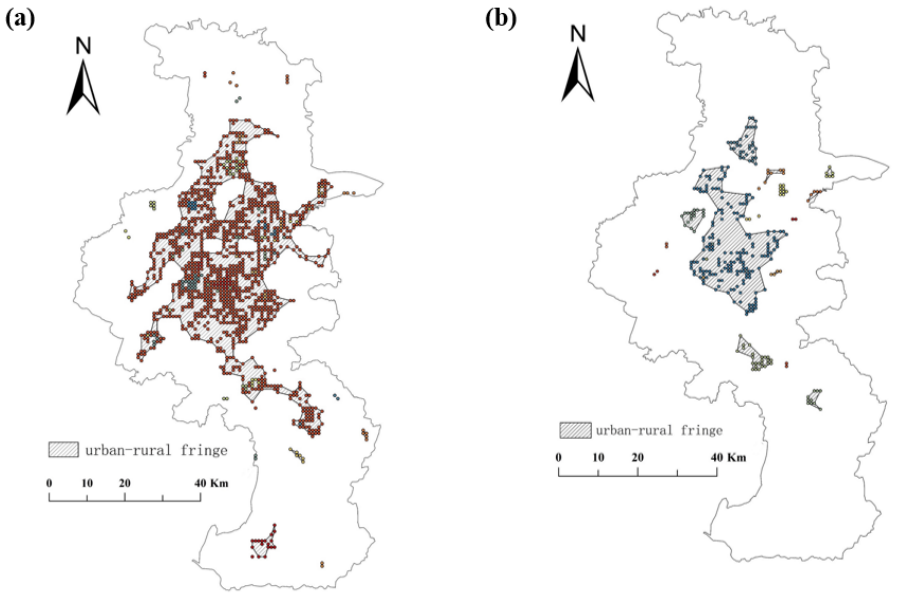
Figure 11. Detection of urban fringe with different slicing thresholds: ( a ) result with k = 0.0; ( b ) result with k = 3.0.